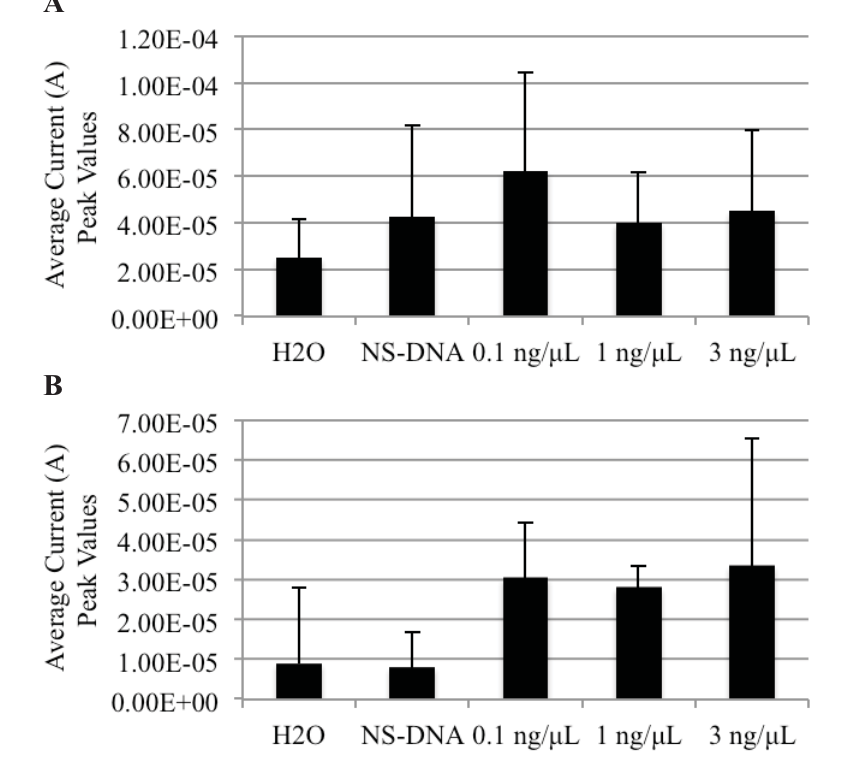
Figure 3. Non-PCR amplified S. enteritidis genomic DNAt can be detected from a mixed DNA culture using the AuNP-DNA biosensor. Graphs represent the average differential current peak values vs. DNAt concentration. ( A ) TRIzol ® extracted genomic DNAt from PBC and ( B ) phenol/ethanol extracted genomic DNAt from PBC. H NS-DNA, non-specific PCR amplified B. anthracis DNAt (0.1 ng/μL) negative control; HCl, 1M hydrogen chloride. Graphs represent the average value of duplicate samples for each condition. Error bars represent the standard deviation of the